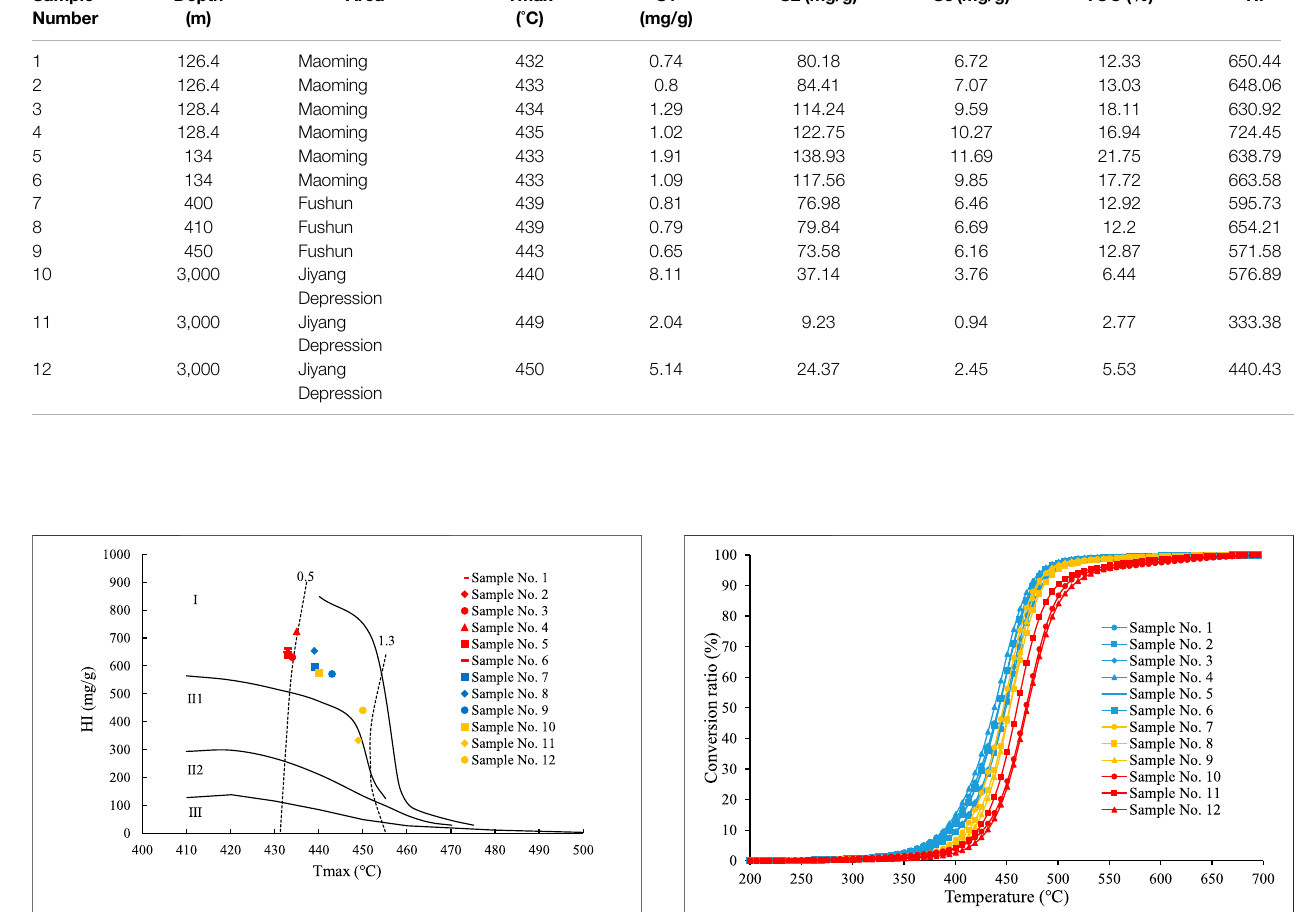
FIGURE 1 | Tmax versus HI diagram of samples.